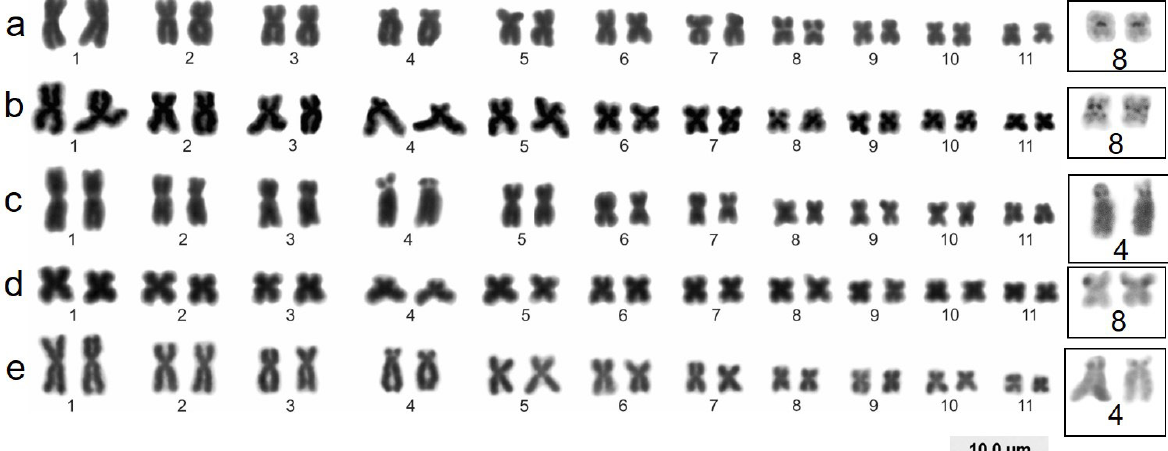
Figure 2. Karyotypes of Proceratophrys species with Giemsa-stained. a) P. schirchi (Santa Teresa, state of Espírito Santo). b) P. laticeps (Santa Teresa, state of Espírito Santo). c) P. melanopogon (Mogi das Cruzes, state of São Paulo). d) P. boiei (Camanducaia, state of Minas Gerais and Mogi das Cruzes, state of São Paulo). e) P. boiei (Tijucas do Sul, São José dos Pinhais, and Morretes, state of Paraná). Boxes refers to Nuclear Organizer Region impregnated with Silver